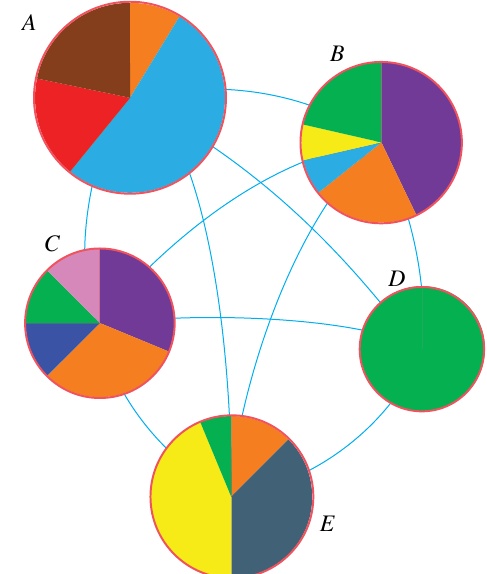
FIG. 8. Communities of the FTSE 100 (log-returns of daily closing prices from 2001Q4 to 2011Q3) generated using our correlation-based modularity Q 3 ð ~ σ Þ with the Louvain algorithm (see the Appendix). Individual communities are labeled A through E , and the pie chart represents the relative composition of each community based on the industry sectors of the constituent stocks (color legend in Table I). The blue intercommunity link weights are negative, indicating that the communities are all residually anti- correlated. The red circles around each community indicate that the total intracommunity correlations are all